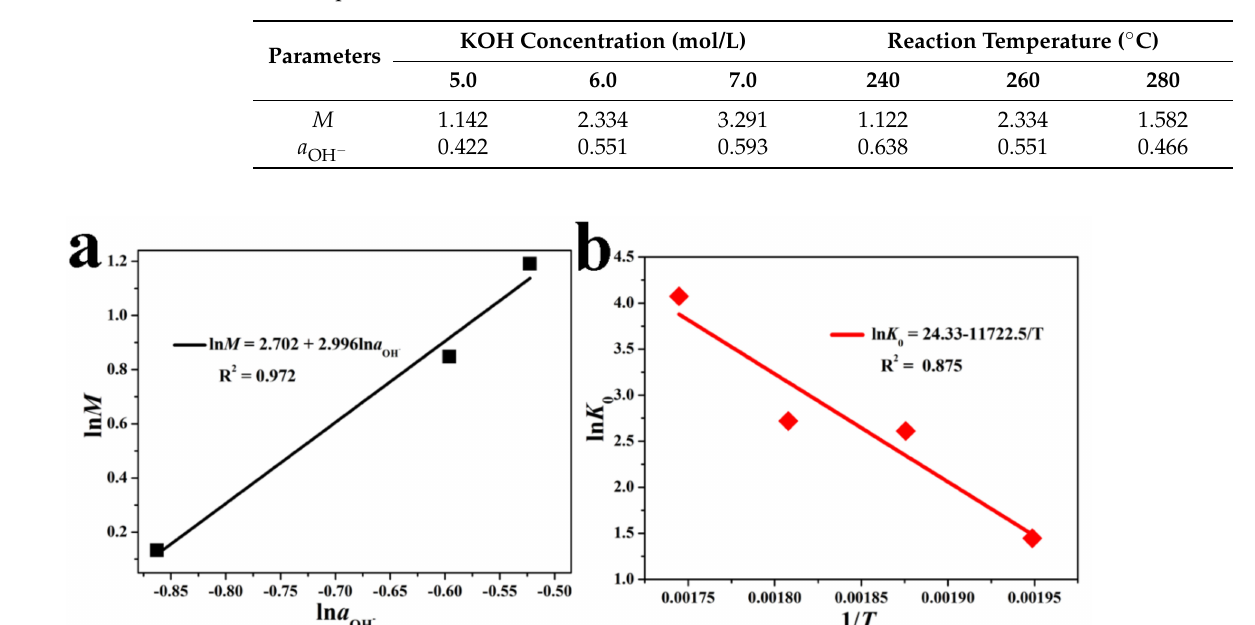
Figure 6. The plot of lnM- ln a